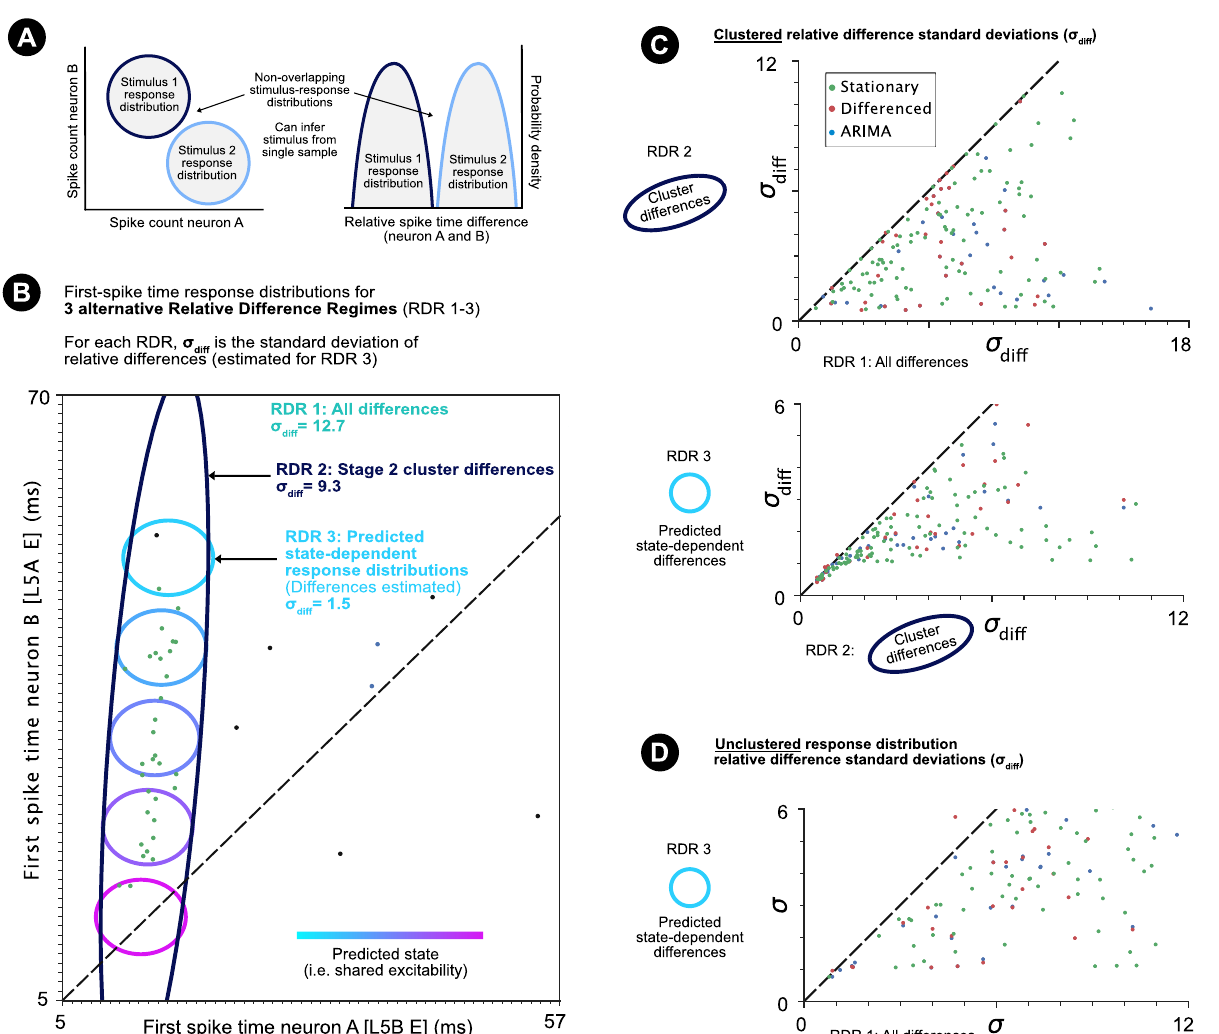
Figure 5. State-dependent coding predictions and relative difference regimes. ( a ) Illustration of two non- overlapping stimulus-response distributions for (left) spike counts and (right) relative spike time differences. ( b ) Sampled first spike response distribution for two neurons (L5B E, L5A E). Point colours illustrate DBSCAN cluster (epsilon = 5.0). Dark blue angled ellipse illustrates 4 σ boundary of Stage 2 ellipse (i.e. the area for which the standard deviation of relative differences is calculated under RDR 2). Coloured circles illustrate the 4 σ boundary of the state-dependent response distribution predicted by factor analysis for single state values ( < 0, 0, > 0 ). The standard deviation of the predicted state-conditioned first spike relative difference distributions (for RDR 3) is calculated based on the size of this area (Methods). ( c ) The standard deviation of differences of RDR 1 vs RDR 2 (top) and RDR 2 vs RDR 3 (bottom) for criteria fulfilling stationary, differenced and ARIMA modelled clusters. ( d ) RDR 2 vs RDR 3 (bottom) for criteria fulfilling stationary, differenced and ARIMA modelled unclustered response clusters are not affected by adaptation, all cluster samples can be used in estimating RDR 2_ σ diff . The smaller first spike pair relative difference standard deviations ( σ diff ) under RDR 2 compared to RDR 1 demonstrates an improved potential encoding capacity for RDR 2 (Fig. 5b,c; Supplementary Video 1). RDR 3 considers that downstream decoding neurons may be modulated by the same shared trial-to-trial changes in the excitability that modulate cluster correlations (i.e. state-dependent-decoding). For example, a higher-level of excitability (i.e. continuous cortical state) on a single trial would decrease the latency of both neurons. Spike times of both neurons would then come from a smaller state-conditioned stimulus-response ◦ distribution. If the cluster correlation is different from 45 , as in Fig. 5b, different state values would correspond with different distributions of relative differences. A downstream neuron modulated by the same trial-to-trial changes in excitability (i.e. continuous cortical state) could respond in a state-dependent manner. Such (smaller) state-conditioned first spike difference stimulus-response distributions would provide a higher coding capacity under state-dependent decoding. To first estimate the size of state-dependent first spike response distributions for each stationary Stage 2 clus- ter, the following linear single factor model was fit to each zero-centred stationary Stage 2 cluster: s i = (cid:31) i η + σ i